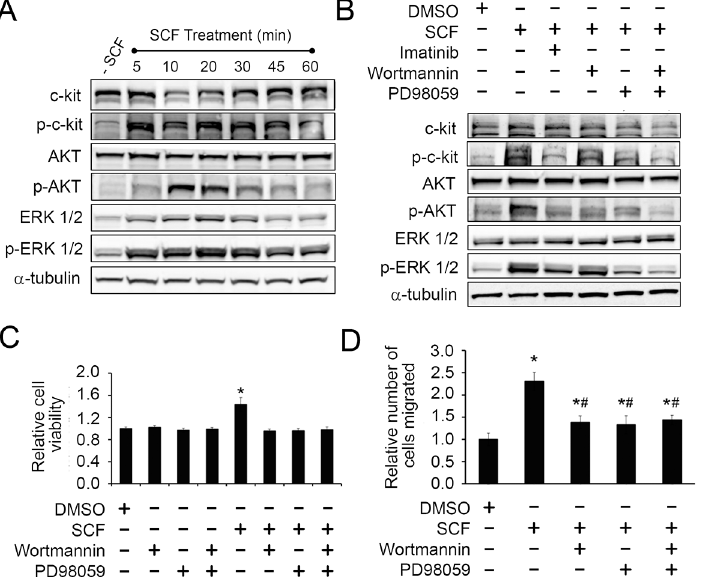
Fig 5. The effects of c-kit activation on CPCs are mediated via the PI3K-AKT and the MEK-ERK pathways. A, Human c-kit+ CPCs were either untreated (- SCF) or treated with 100 ng/ml SCF for the indicated duration. Levels of the indicated proteins at each time point were analyzed by Western blot. p-, phosphorylated (i.e., activated) form. B, CPCs were pre-treated with the indicated inhibitors for 2 hr followed by 20 min of SCF treatment. Levels of the indicated proteins were analyzed by Western blot. Imatinib, a c-kit inhibitor; Wortmannin, a PI3K inhibitor; and PD98059, a MEK inhibitor. C, Cell viability assay. CPCs were cultured in serum-free medium for 3 days in the presence (+) of absence (-) of SCF and the indicated inhibitors. Cell viability was assessed using PrestoBlue TM . D, Boyden chamber assay for cell migration. CPCs were plated in the transwells. After 24 hr, they were pre-treated with the inhibitors for 2 hr, and SCF was then added to the bottom chamber. Migrated cells were fixed, stained with propidium iodide, and counted. All values are normalized to the DMSO (vehicle) control. Values presented are mean ± SEM. * , p < 0.05 compared to the DMSO control. #, p < 0.05 compared to the SCF only treatment group.